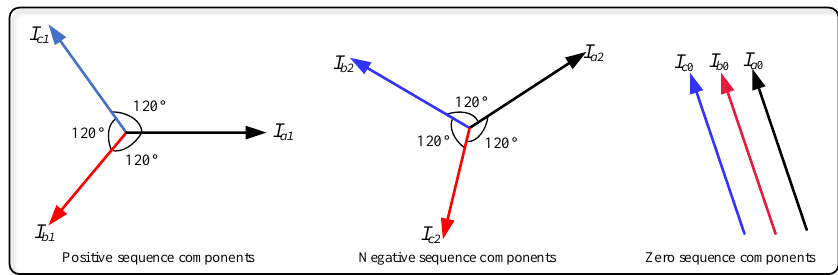
Figure 4. Representation of symmetrical components.